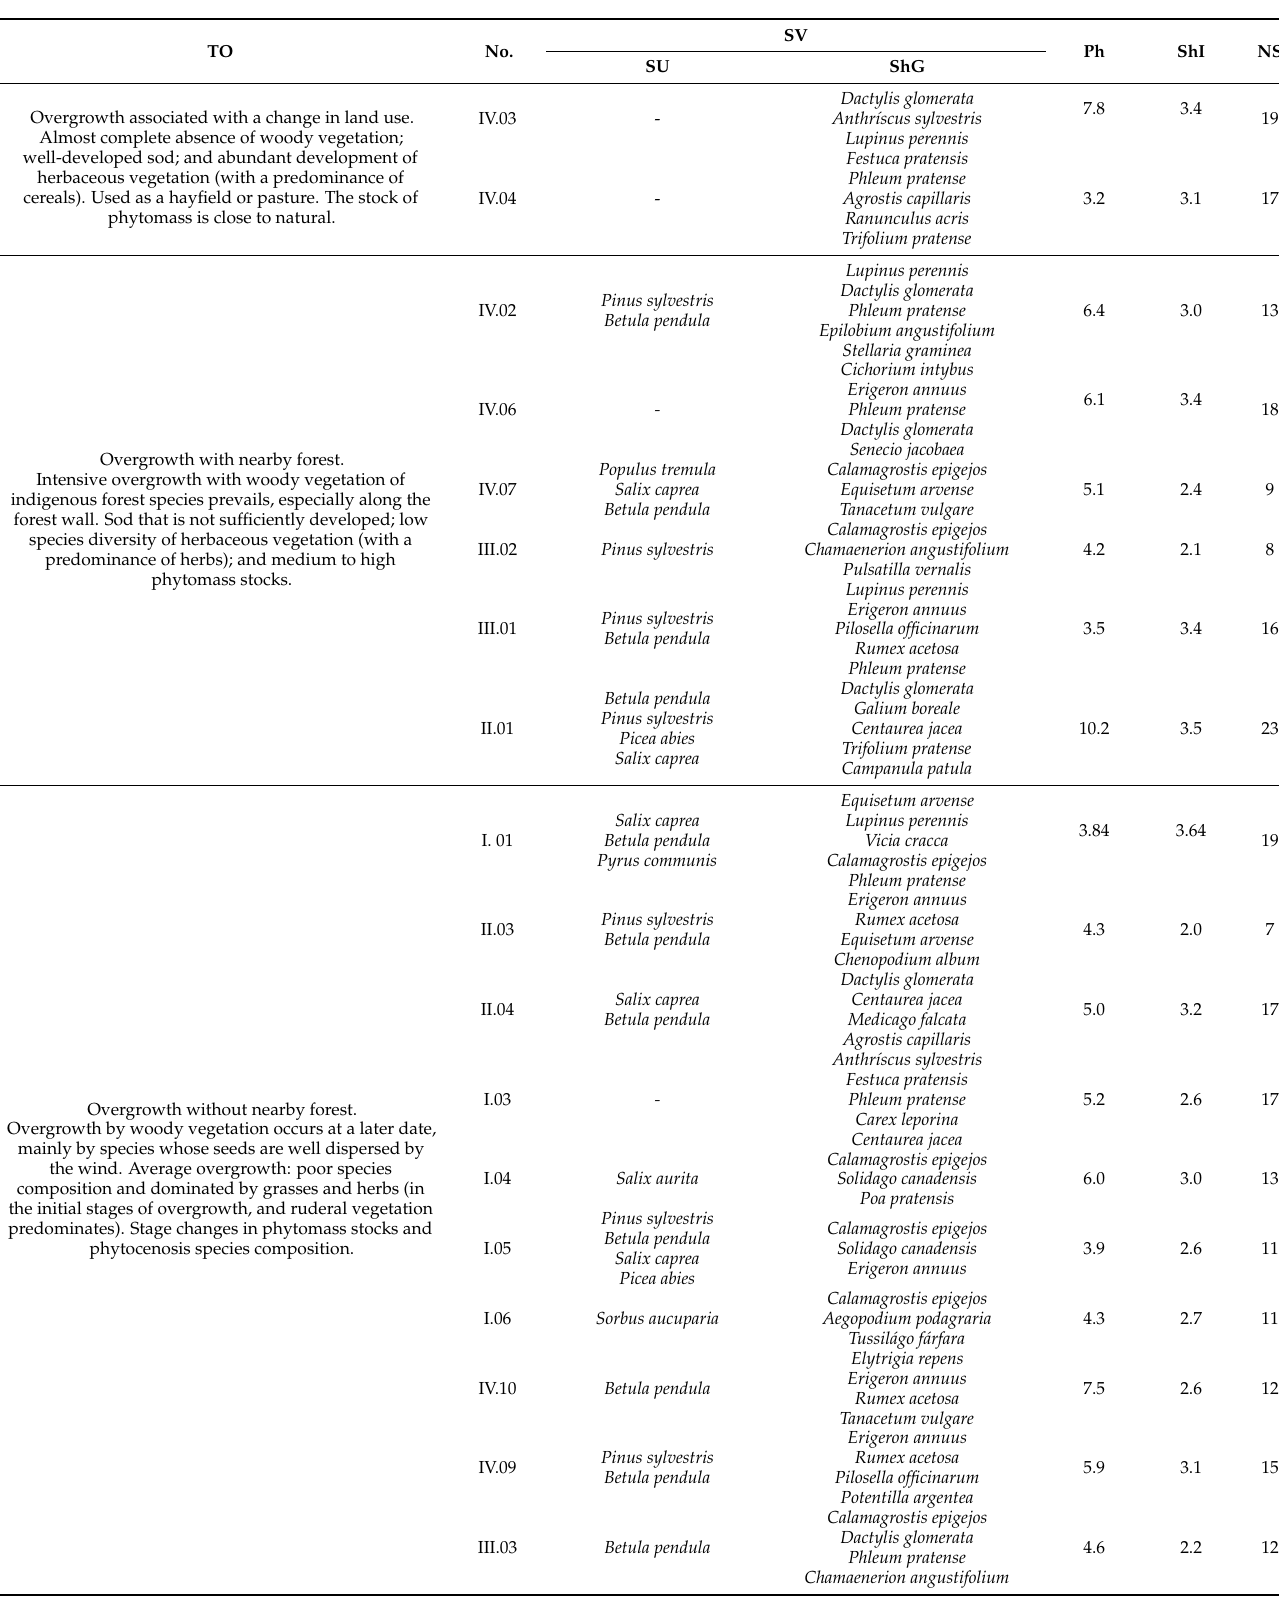
Table 3. Post-agrogenic system transformation types (based on 2018–2019 field